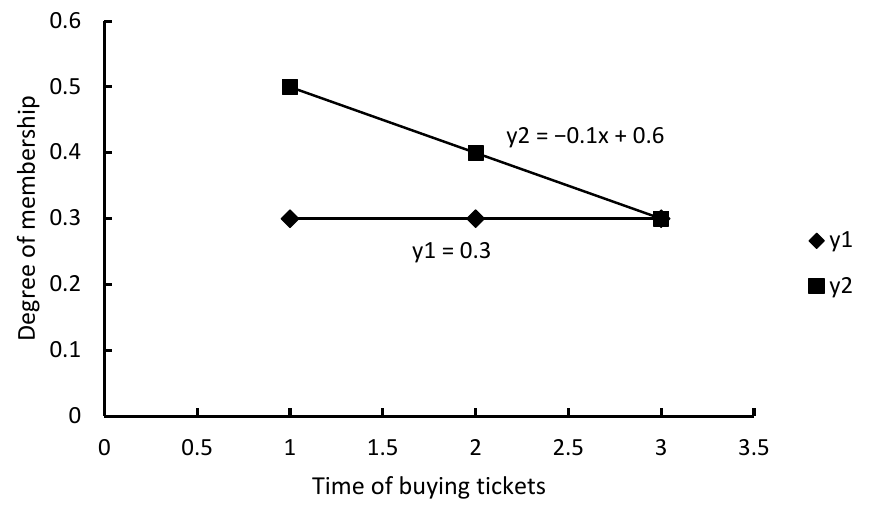
Figure A32. Single factor evaluation for the index of time of buying tickets (1–3 days before departure).